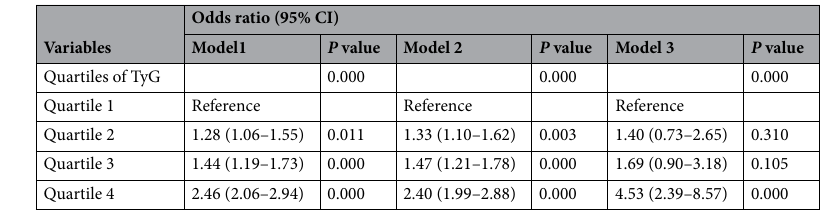
Table 2. Cross-sectional analysis of the association between the baseline TyG index and the incidence of hyperuricemia. CI confidence interval. Model 1: no adjustment; Model 2: adjusted for age, gender. Model 3: adjusted for all the factors in model 1 and HDL-C, LDL-C, BMI, eGFR, 24hTP, SBP, DBP, HbA1c.